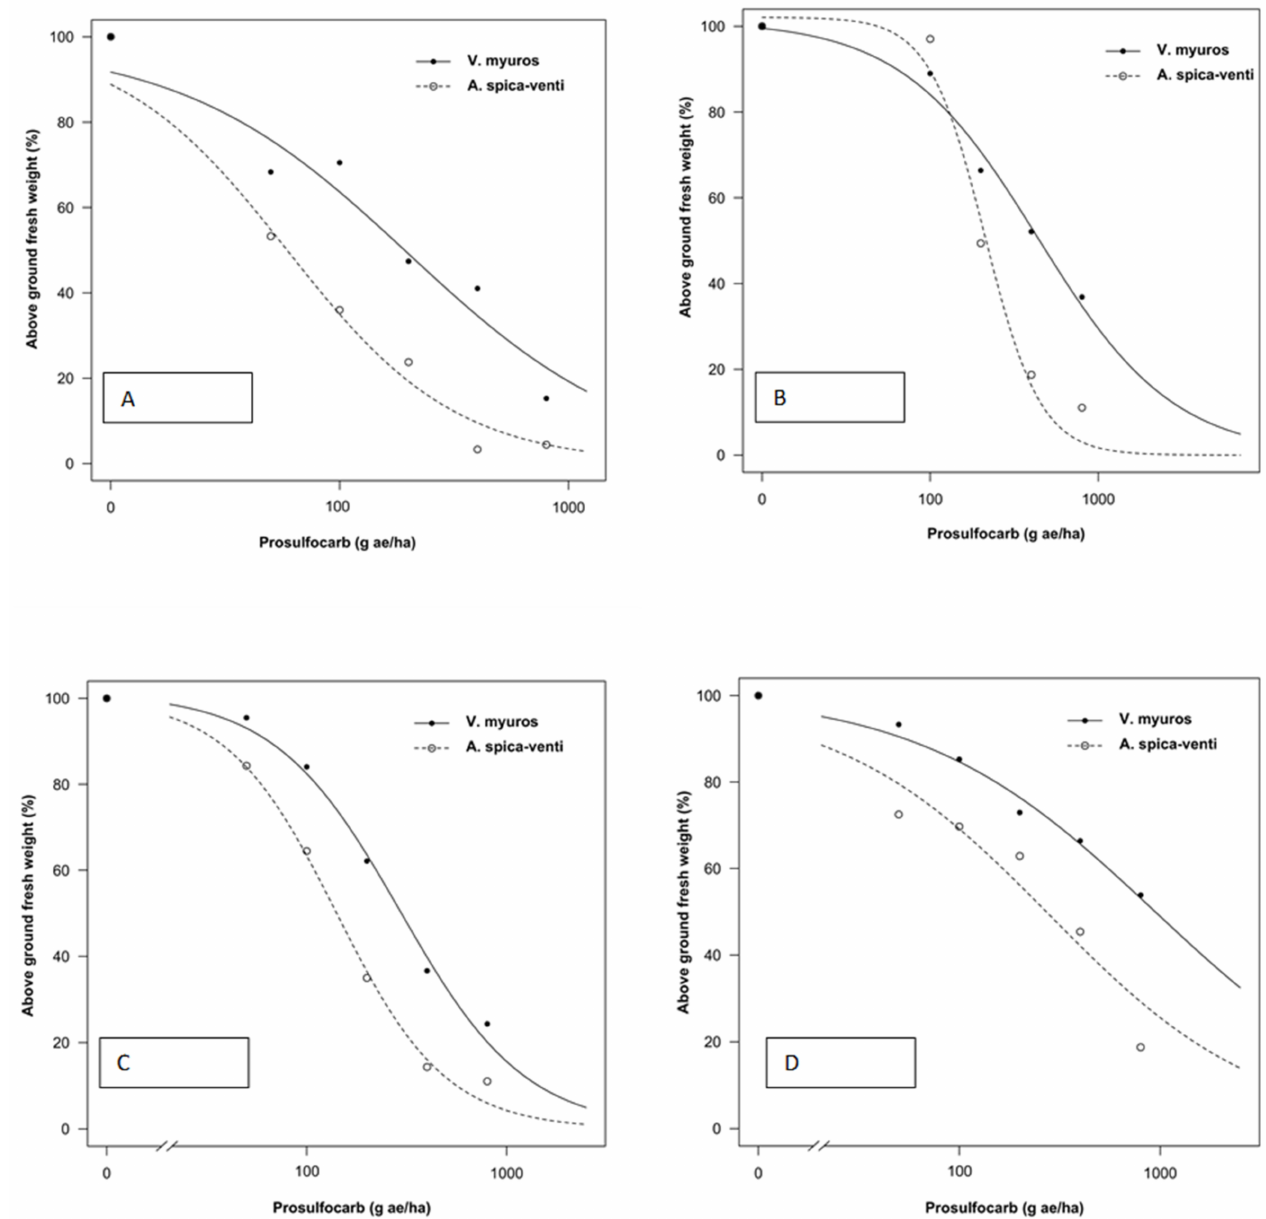
Figure 1. Prosulfocarb dose–response on aboveground fresh weight represented as percentage of untreated control of Vulpia myuros and Apera spica-venti in Experiment 1 at: BBCH 00 ( A ); BBCH 11 ( B ); BBCH 12 ( C ); and BBCH 13 ( D